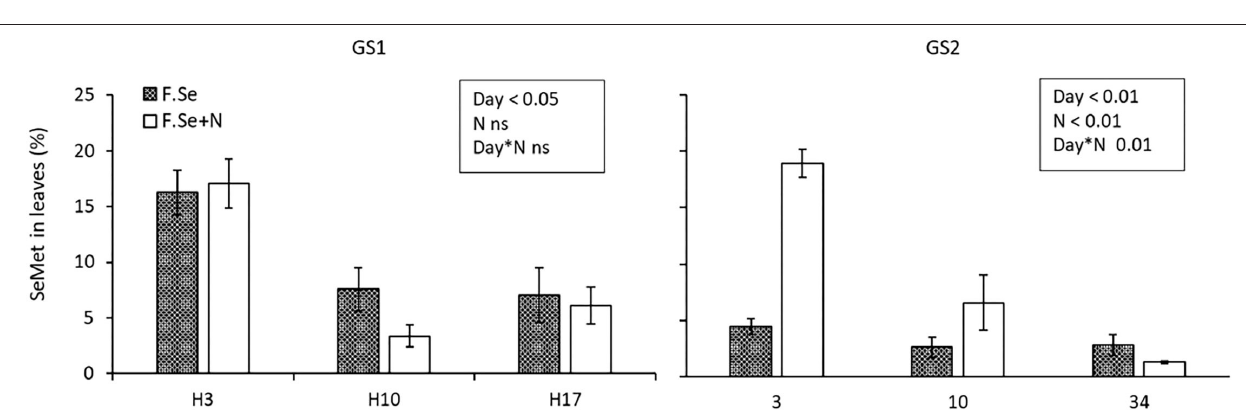
Plant biomass was not influenced by the different Se